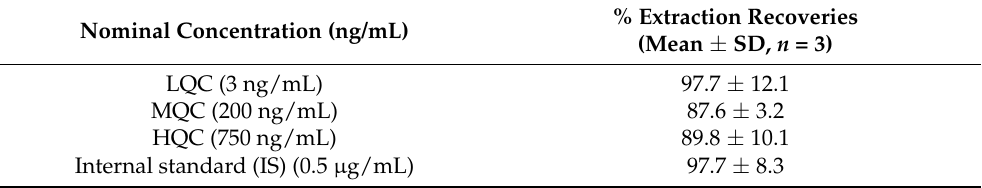
Table 3. Assessment of the % extraction recovery of ICG in rat plasma (Mean ± SD, n = 3).